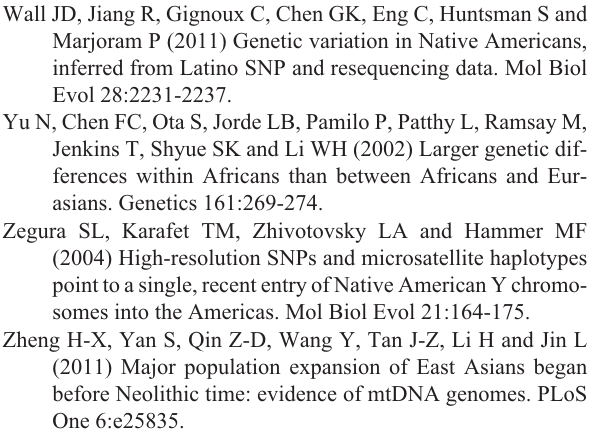
Table S2 – Pairwise (cid:2) for each locus. ST Table S3 – Estimated substitution rates ( (cid:5) ) for each locus. Figure S1 – Posterior density of effective population sizes for Asian vs. Native Americans. Figure S2 – Posterior density of effective population sizes for Chinese vs. Native Americans. Figure S3 – Posterior density of effective population sizes for Chinese vs. Siberians. Figure S4 – Posterior density of effective population sizes for Siberian vs. Native Americans. Figure S5 – Posterior density for migration parameters for all scenarios. Figure S6 – Posterior density for divergence times (in years) for all scenarios. Figure S7 – Posterior density for the splitting parameter s for all scenarios. Figure S8 – Posterior density for the effective size of the founder population for Native Americans, from Asia, with or without migration. Figure S9 – Posterior density for the effective size of the founder population for Native Americans, from Chinese, with or without migration. Figure S10 – Posterior density for the effective size of the founder population for Siberians, from Chinese, with or without migration. Figure S11 – Posterior density for the effective size of the founder population for Native Americans, from Siberians, with or without